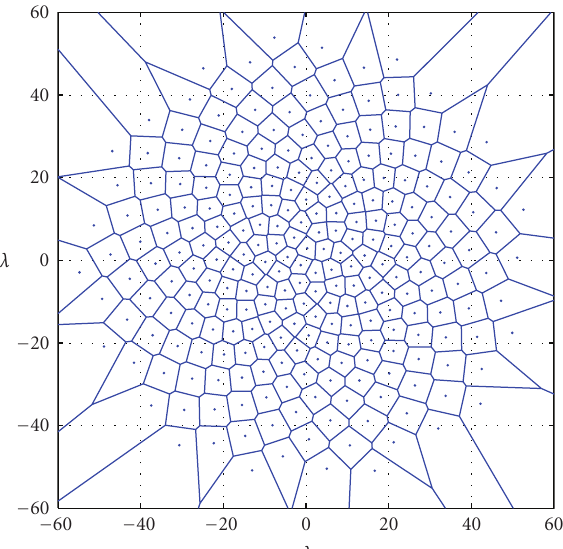
Figure 5: The Voronoi tessellation consisting of the cells enclosing the chosen phase centers.